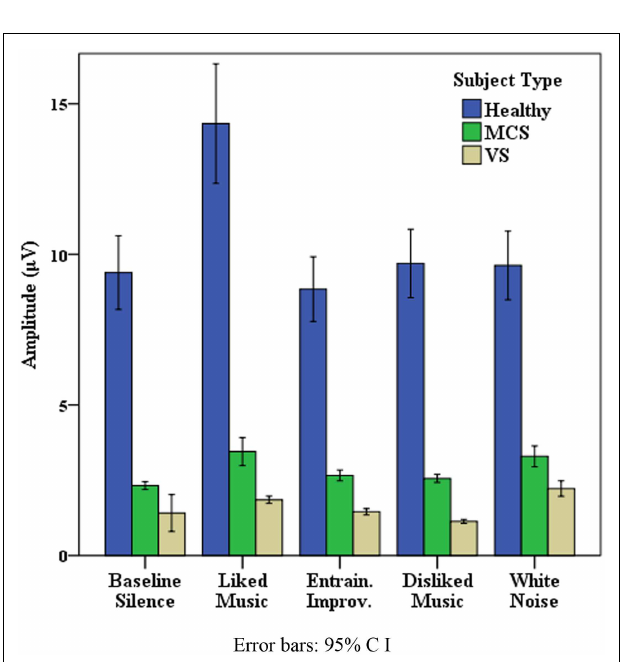
FIGURE 4 |Vegetative state blink rate .